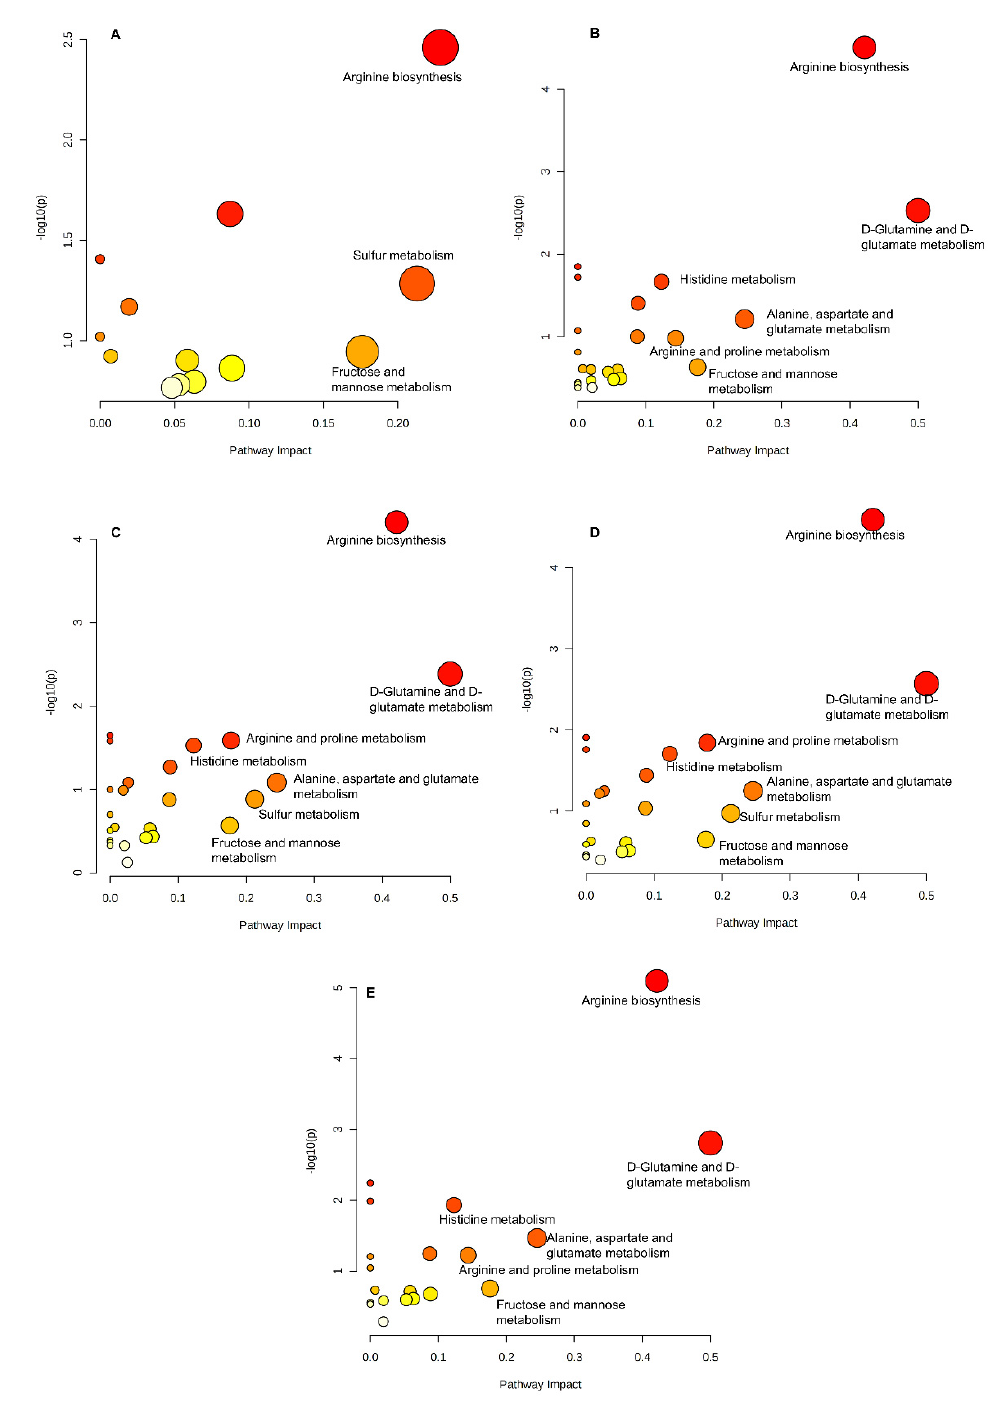
Figure 7. Summary of pathways analysis of mice with CCFM8610 treatment with MetaboAnalyst. ( A ), CCFM8610 only treatment groups; ( B ), CdCl 2 treatment groups; ( C ), Cd–citrate treatment groups; ( D ), Cd–GSH treatment groups; ( E ), Cd–MT treatment groups.